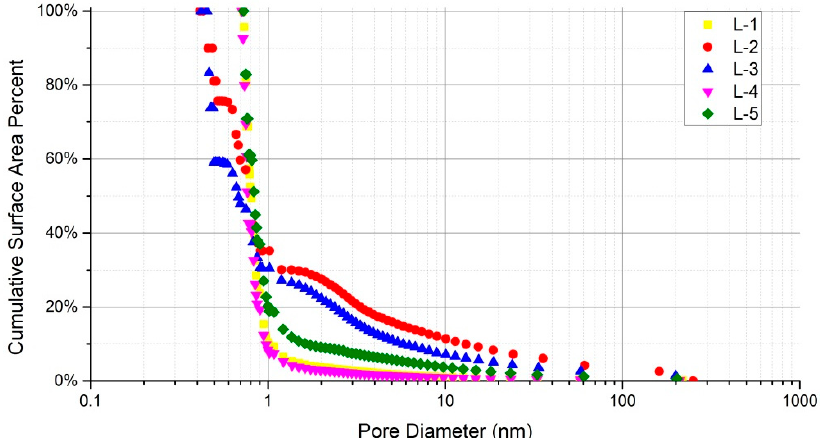
Figure 6. Pore size distribution by percent cumulative surface area for the five selected samples in Table 1. Notice that we use logarithmic coordinates on the X -axis.